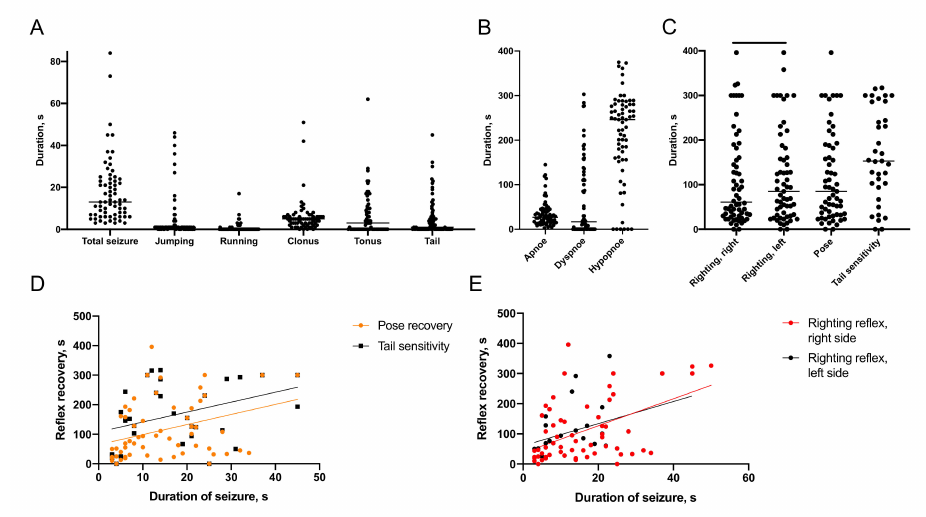
Figure 1. Seizure semiology. ( A )—Duration of seizure episodes and their elements. ( B )—Duration of respiratory distur- bances. ( C )—Duration of reflexes recovery. ( D , E )—Correlations between the duration of immediate seizure episodes and recovery after TBI. ( A )—Righting reflex recovery. ( B )—Posture and tail sensitivity recovery. p < 0.05, Wilcoxon test (n = 67); for all correlations p < 0.05 (n =